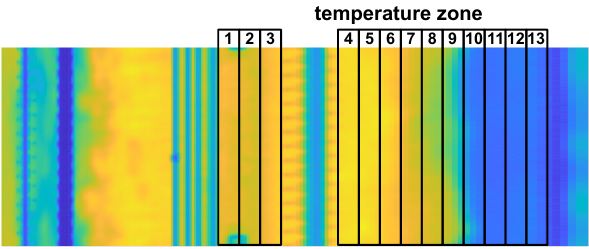
Figure 2. Visualization of the selected kiln-shell temperature zones.